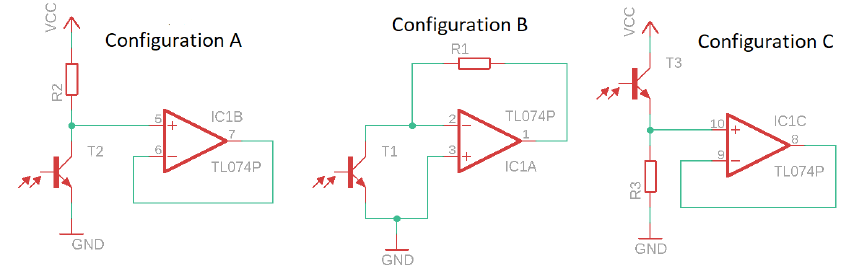
Figure 6. Evaluated configurations for the transimpedance circuit.